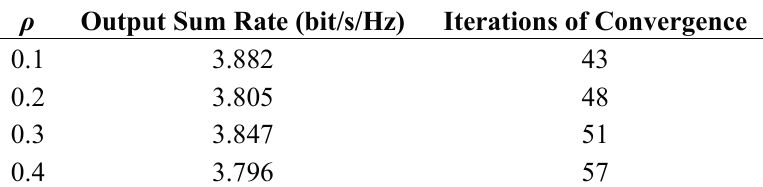
Table 1. The influence of the pheromone volatilization coefficient ρ .